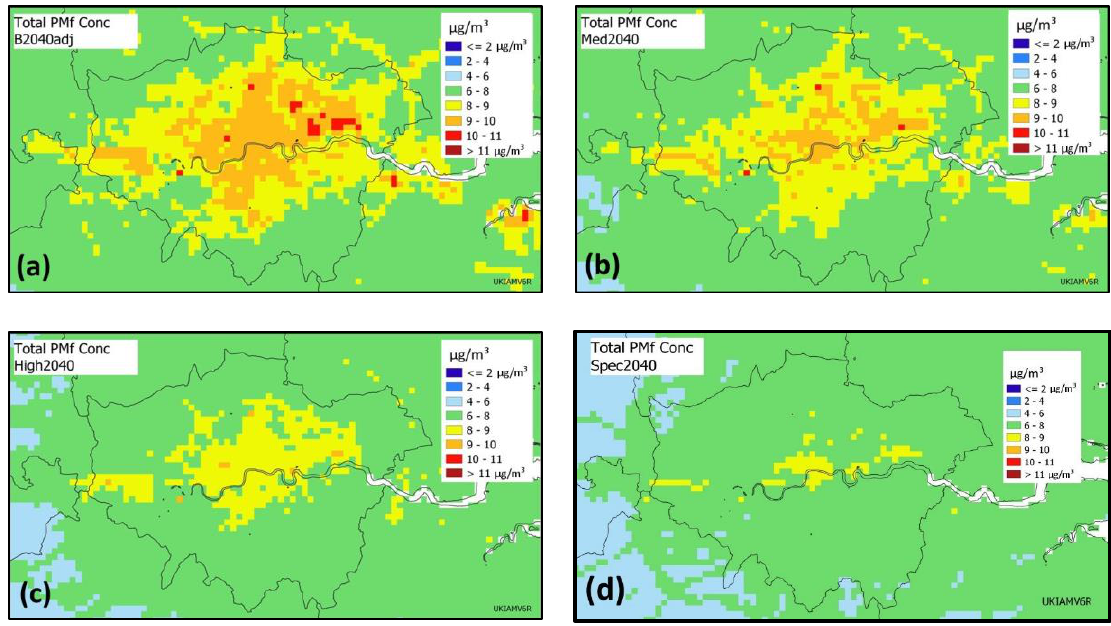
Figure 8. In 2040, ( a ) the baseline and ( b ) the medium scenario show large areas of London remain at risk of exceedance, whereas ( c ) the high ambition and ( d ) the speculative scenario almost remove all areas (orange) at risk of exceeding exceeding 10 µg m − 3 .